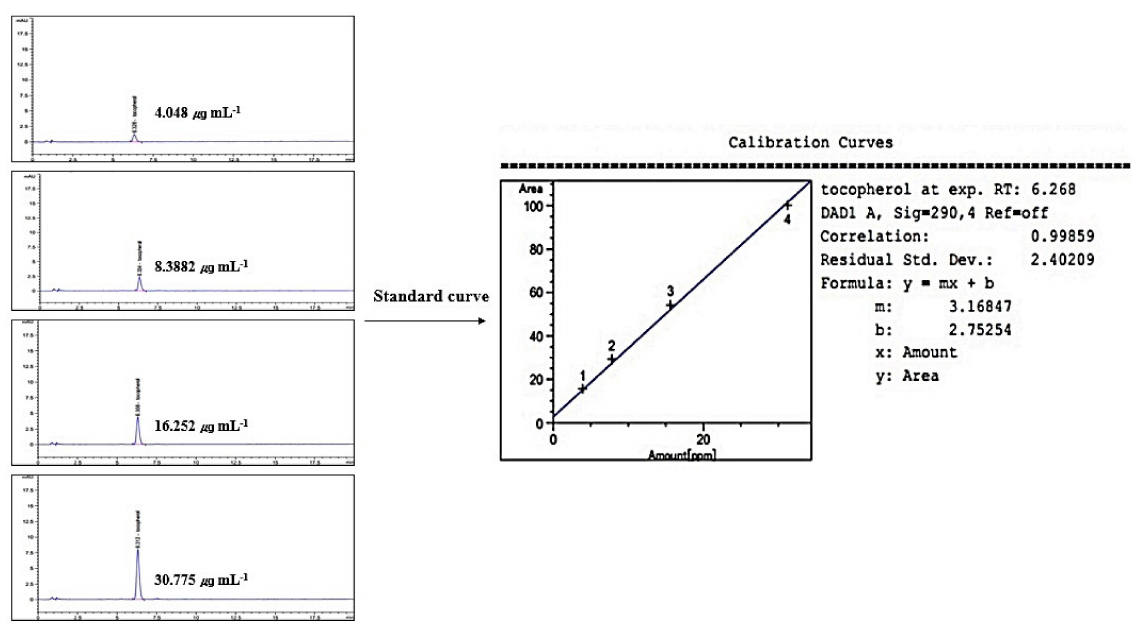
Figure 8. Standard curve for HPLC/UV analysis of γ -Tocopherol (wavelength: 290 nm).